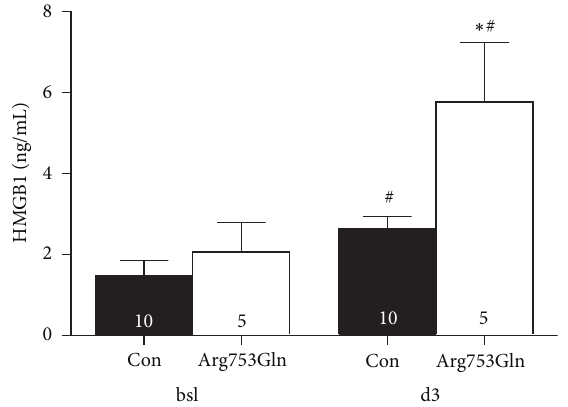
Figure 4: Patients undergoing coronary artery bypass surgery with extracorporeal circulation displayed increased HMGB1 serum levels on day 3 after surgery compared to baseline ( # 𝑃 < 0.05 versus bsl). Heterozygous carriers of the less-functional Arg753Gln TLR2 polymorphism showed significantly higher levels compared to healthy controls (con). 𝑛 = 5 –10, ∗ 𝑃 < 0.05 versus